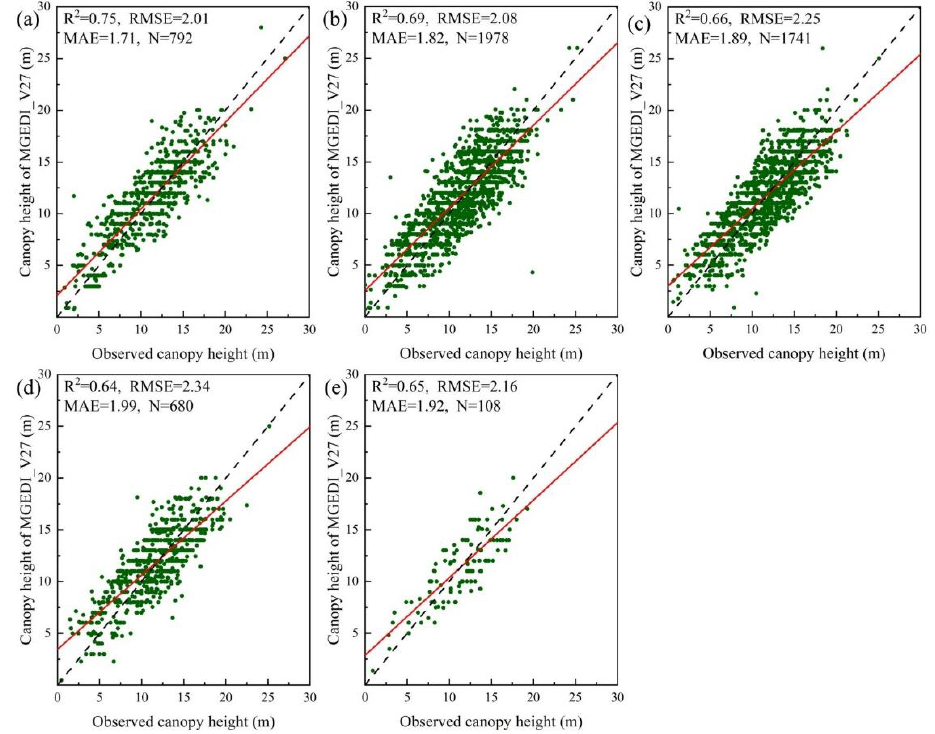
Figure 18. Canopy height accuracy of the MGEDI_V27 at five slope levels. ( a ) 0 – 10°. ( b ) 10 – 20°. ( c ) 20 – 30°. ( d ) 30 – 40°. ( e ) >40°.